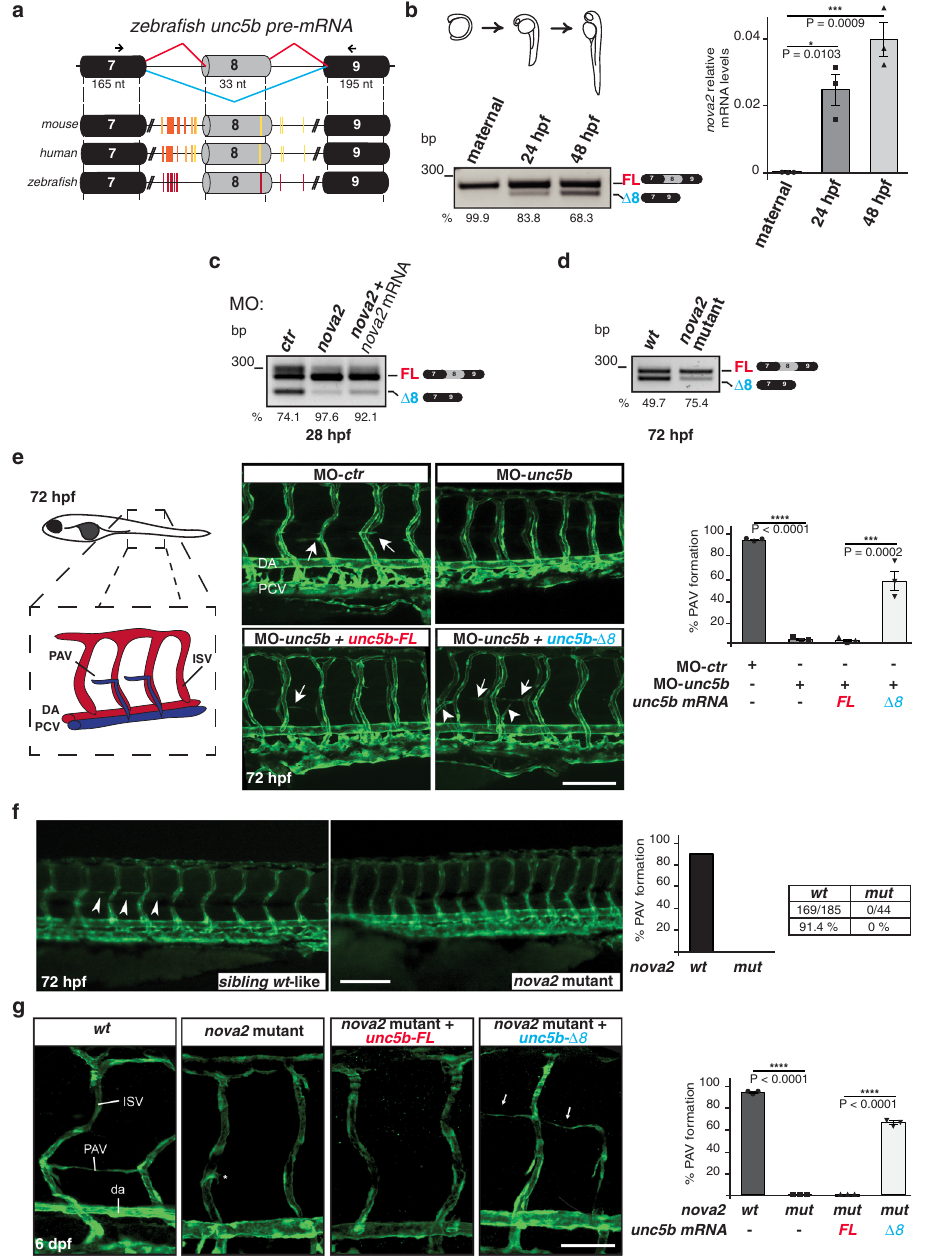
Fig. 3 Unc5b- Δ 8 promotes PAV vessel formation in zebra fi sh. a Schematic representation of mouse, human, and zebra fi sh unc5b genomic regions with the AS exon 8 in gray. Black boxes = constitutive exons; lines = introns. YCAY motifs identi fi ed with RBPmap tool are indicated as vertical bars. Arrows indicate primers for RT-PCR. b Splicing analysis of unc5b exon 8 and nova2 mRNA expression levels in zebra fi sh embryos at different developmental stages: maternal, 24 h post-fertilization (hpf), and 48 hpf. c RT-PCR with RNA extracted from zebra fi sh embryos (28 hpf) injected with a control morpholino (MO- ctr ) or a morpholino against nova2 (MO- nova2 ). Altered AS was partially corrected by the co-injection of a morpholino-resistant nova2 mRNA (MO- nova2 + nova2 ). n = 6. d Compared to the wild-type (wt) organism, nova2 mutants show a reduction of the unc5b- Δ 8 transcript (72 hpf). The percentage of exon inclusion is indicated. n = 3. e Left: scheme of zebra fi sh vessels; PAV parachordal vessel, DA dorsal aorta, PCV posterior cardinal vein, ISV intersegmental vessel. Central: lateral views ( fl uorescence) of Tg(kdrl:GFP) la116 zebra fi sh embryos (72 hpf) injected with a control morpholino (MO- ctr ) or with a morpholino against unc5b (MO- unc5b ); unc5b morphants were also co-injected with morpholino-resistant zebra fi sh mRNAs encoding for unc5b AS isoforms ( unc5b-FL or unc5b- Δ 8 ). Right: quanti fi cation of embryos in which PAV is correctly formed (%). n = 3. Arrows indicate correctly forming PAV, whereas arrowheads indicate those unproperly forming. f Left: Lateral views ( fl uorescence) of 72 hpf wild-type ( wt ) and nova2 CRISPR mutant zebra fi sh embryos. Right: Quanti fi cation of PAV formation in 72 hpf wild-type (wt) and nova2 mutant ( mut ). N. of larvae with normal PAV out the total n. of larvae. Arrowheads indicate forming PAV. g Left: lateral views ( fl uorescence) of wt and nova2 mutant embryos (6 dpf) injected with mRNAs encoding for unc5b AS isoforms ( unc5b-FL or unc5b- Δ 8 ). Arrows indicate forming PAV. Right: quanti fi cation of embryos in which PAV is correctly formed (%). n = 3. n = biologically independent experiments. One-way ANOVA for multiple comparisons; Error bars indicate ±SEM. Exact P values are indicated: * P < 0.05; *** P < 0.001; **** P < 0.0001. Scale bars: 50 μ m in e , 100 μ m in f , 25 μ m in g